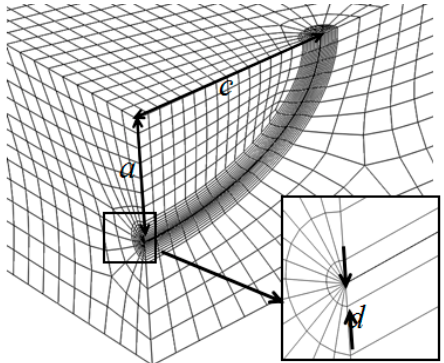
Figure 9. One-quarter model for the semi-elliptical crack in a rectangular plate.